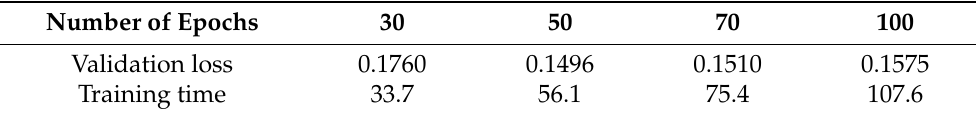
Table 4. Validation losses and training time (s) of the seq2seq module under different epochs while the number of nodes of FC1 is 64 and number of units of LSTM is